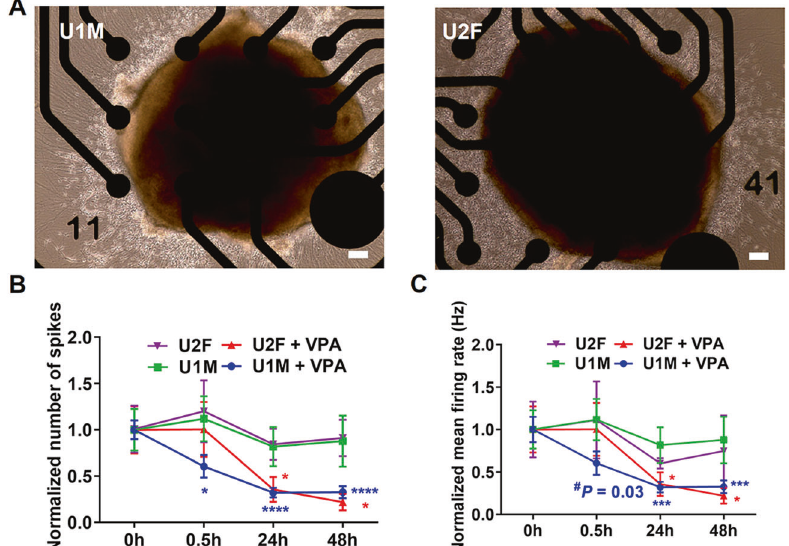
Fig. 5 VPA affects synaptic transmission in hFOs. A Bright fi elds for hFOs cultured on the MEA plate. Scale bar, 100 μ m. B , C Number of spikes ( B ) and mean neuron fi ring rate ( C ) post VPA exposure. Data were shown as Mean ± SEM (averaged organoids N = 7 from two batches). Number of spikes and mean neuron fi ring rate in the control groups (0 h) were normalized to 1. The student ’ s t -test was used to assess differences between the control (0 h) and the other VPA-exposed group (30 min, 24 h, 48 h). # P < 0.05, one-tailed t -test. * P < 0.05, *** P < 0.001, **** P < 0.0001, two-tailed t